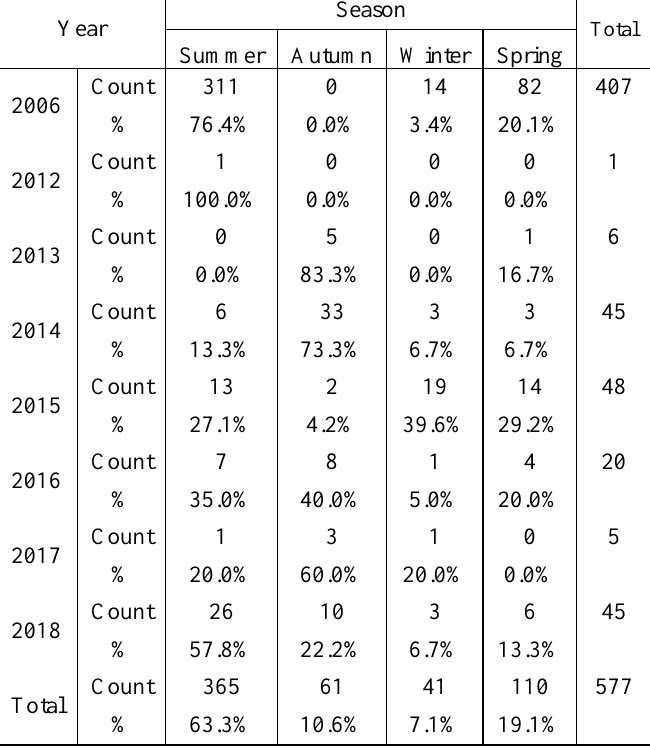
Table 2: Temporal Distribution of LSD in Egypt during 2006-2018: